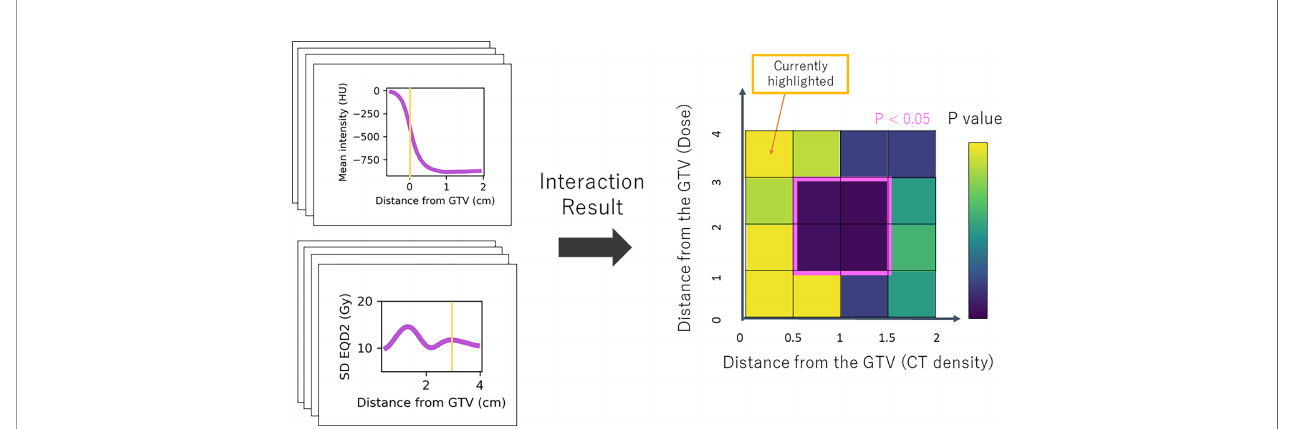
FIGURE 3 | Simpli fi ed schematic of the Cox-per-radius method. The value of density feature and dose parameter is extracted at combinations of distance from the GTV for every patient. These values are used to build the Cox models and assess the signi fi cance of the interaction term. The p-value of the interaction term from a likelihood-ratio test is included in the heatmap at the distance combination. The example highlighted shows mean density at 0 cm from the GTV and standard deviation dose at 3 cm. The corresponding p-value for this interaction is included at (0,3) on the map. An example signi fi cant region demonstrates an interaction between density 0.5 and 1.5 cm from the GTV and dose 1 – 3